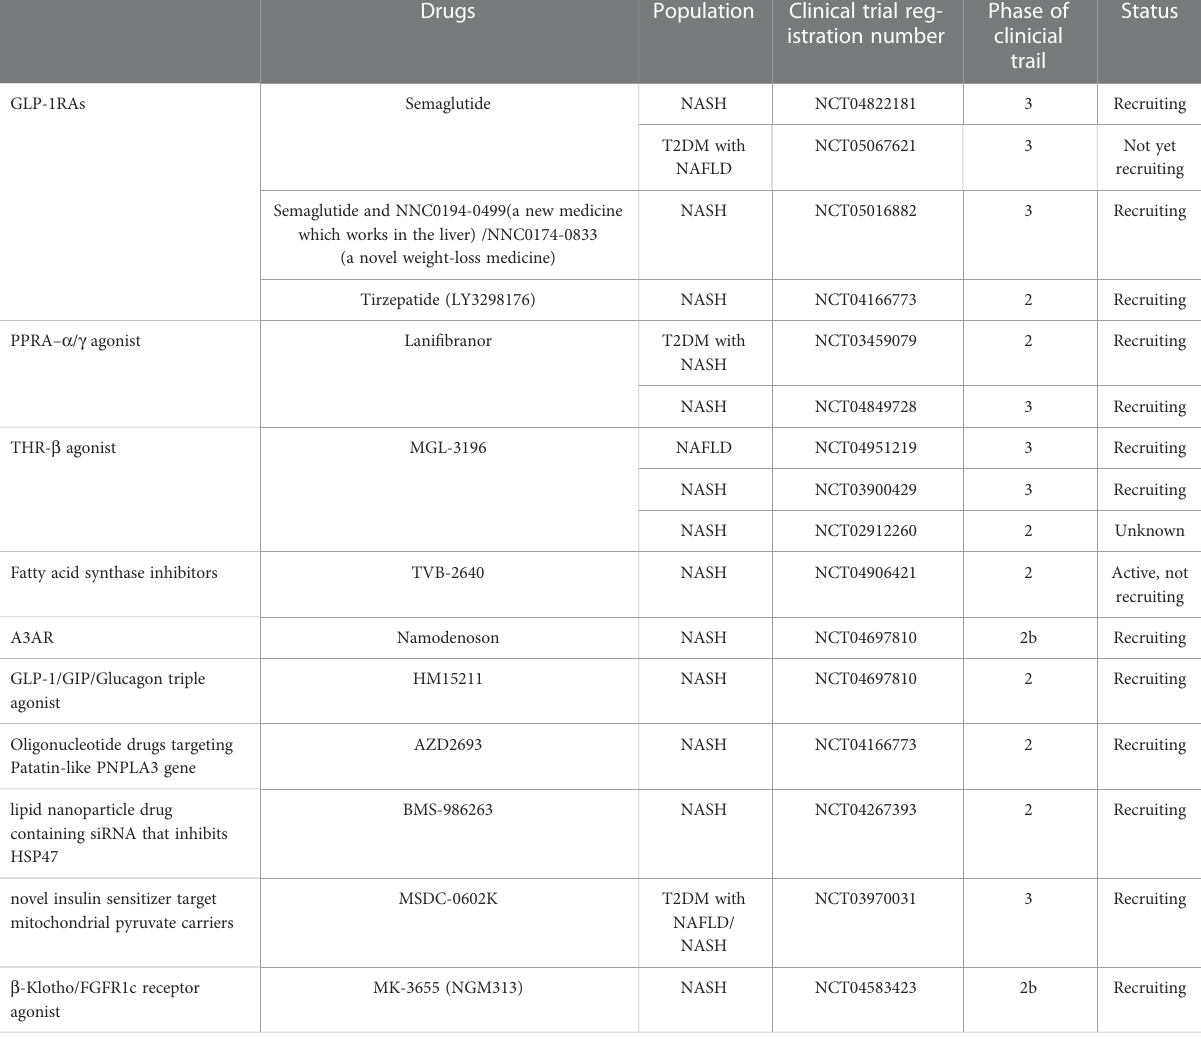
TABLE 4 Partial drug clinical trials in progress or in preparation (data from